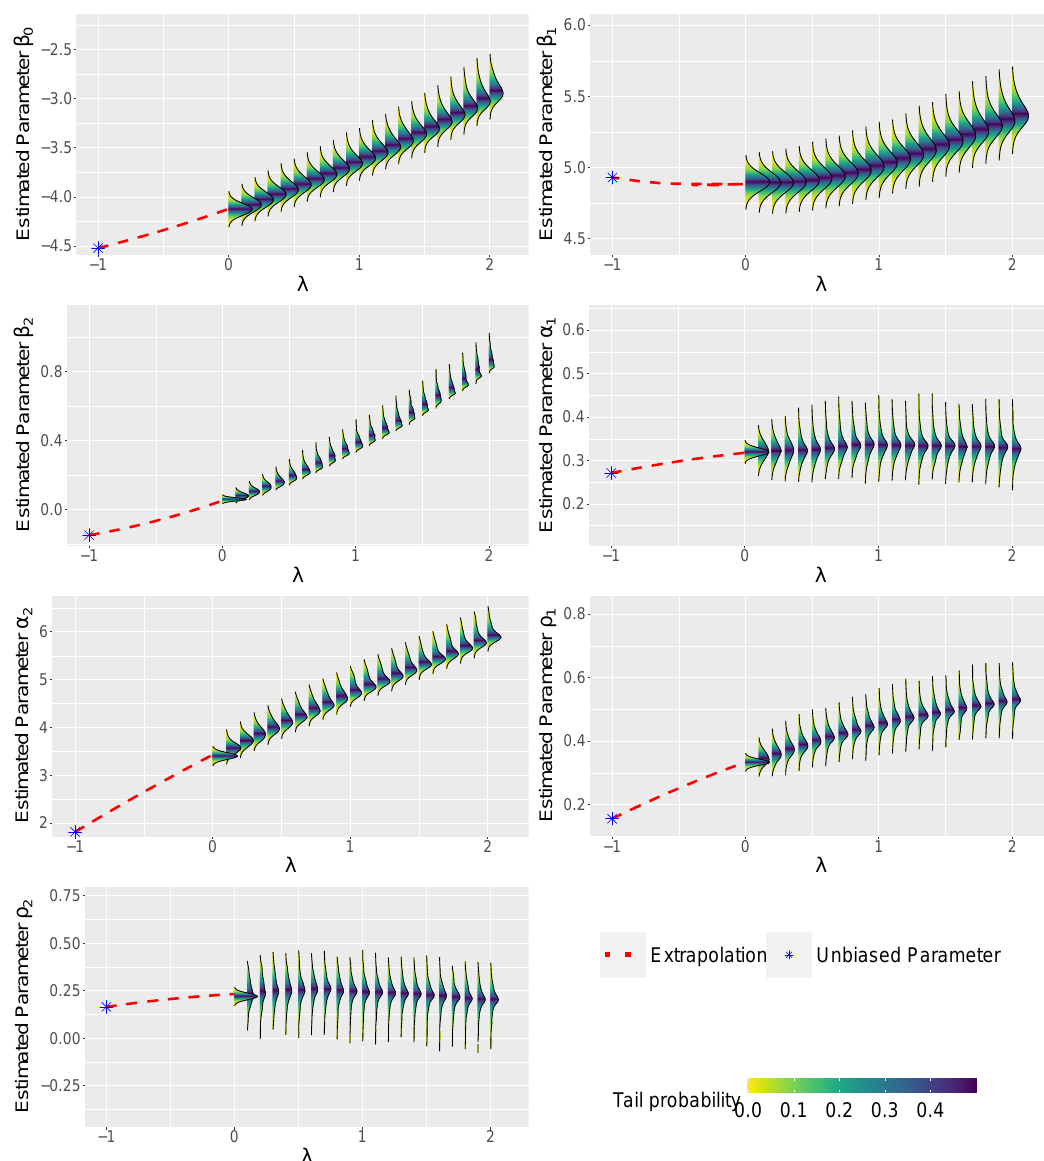
Figure 5. Results from the simulation-extrapolation (SIMEX) method for reducing the effects of measurement error on the parameter value for Model 9 to estimate normalized difference moisture index (NDMI). As error was increased from 0 to 2 ( λ ), 1000 simulations were conducted and the new parameters were recorded. A quadratic linear model was used to fit the simulations and extrapolate to a λ level of − 1, as if there was no measurement